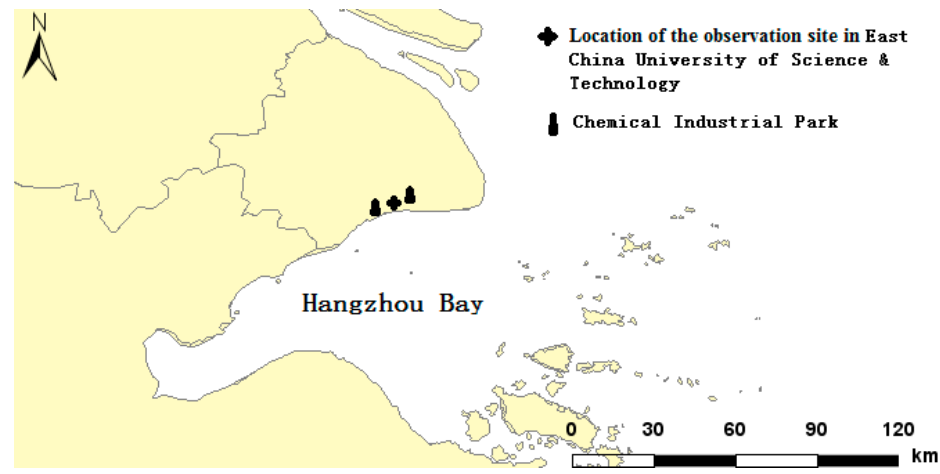
Figure 1. Location of the observation site.